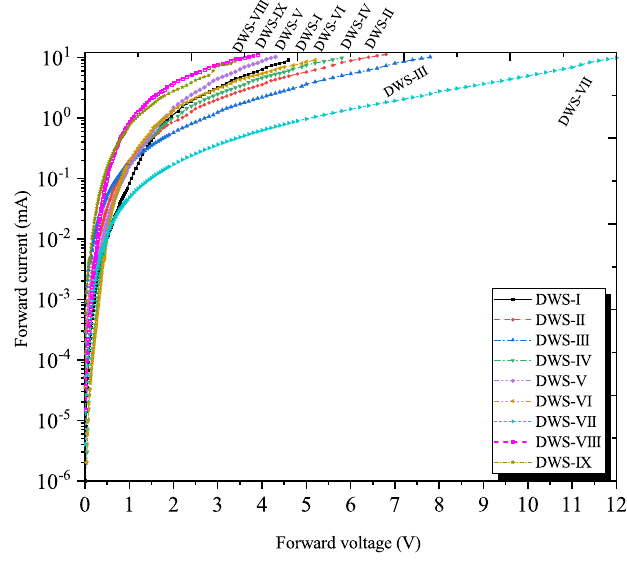
Figure 2. Current-voltage characteristics of p -type 4H-SiC (DWS# I-IX) SBD illustrating the effect of tunneling and showing a decrease in the bulge in current as voltage